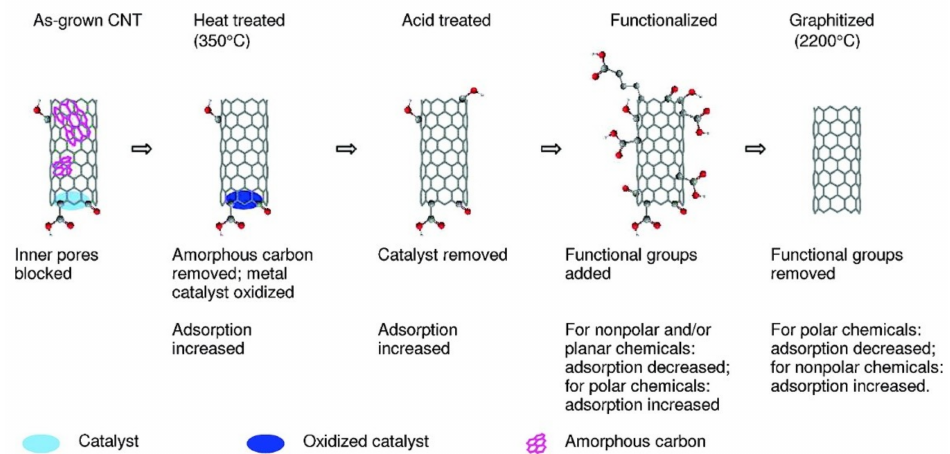
Figure 1. The general trend for the changes of CNT adsorption properties after different treatments. Reprinted with permission from [23]. Copyright (2008) American Chemical Society.